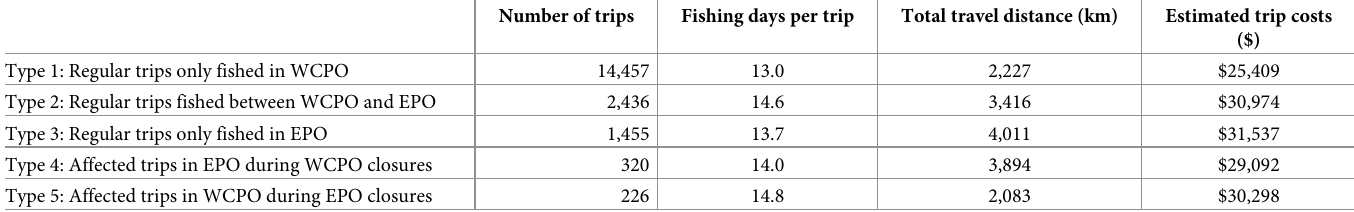
Table 10. Quantitative results for fishery policy